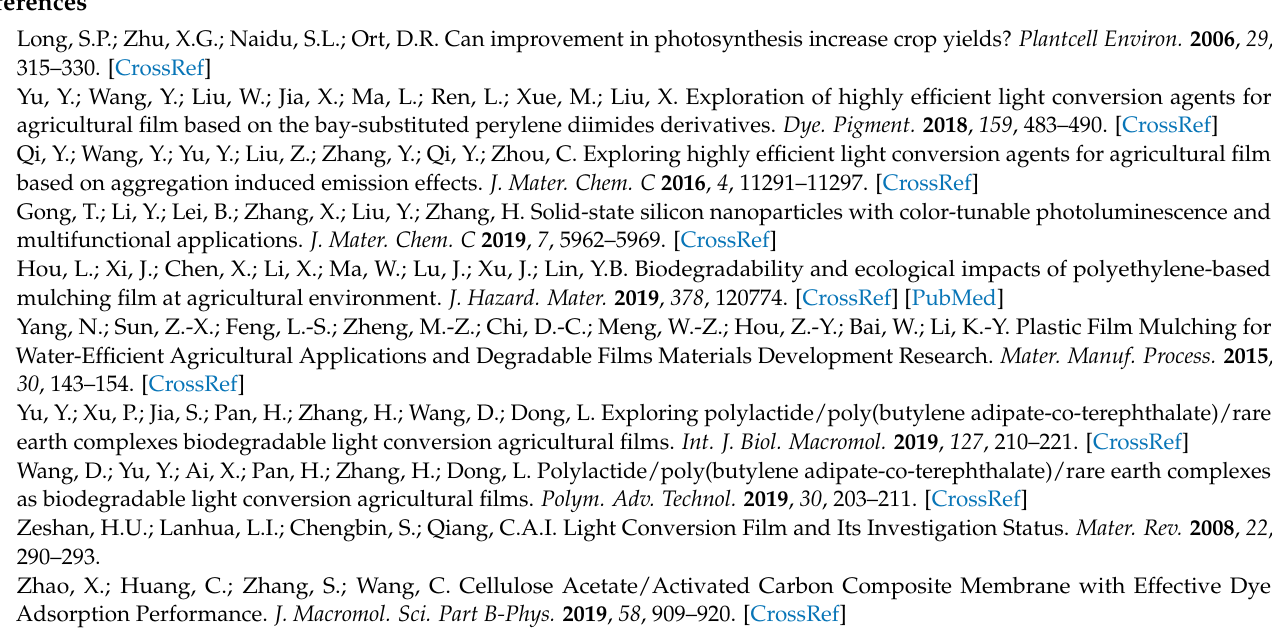
Table S1: The characteristic FTIR data of the pure CA and light conversion films, Table S2: Binding energy of C1s and O1s for CA and light-conversion films, Table S3: The conditional viscosity of CA and CA-Eu